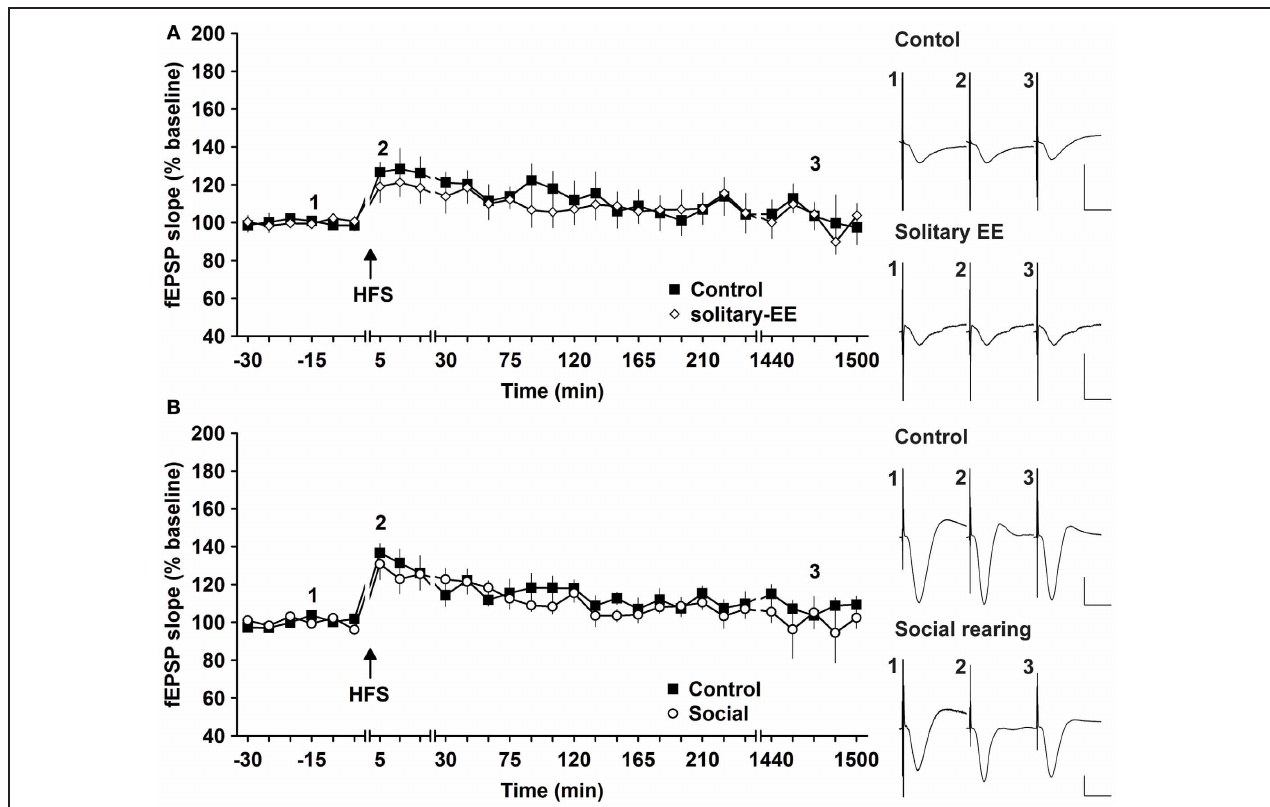
housing in the absence of EE had no effect on E-LTP. Time-point of high frequency stimulation (HFS) is marked with a filled arrow. Insets: Analog examples of field potentials (averages of five consecutive sweeps) from typical experiments at the time indicated by the numbers. Horizontal bar: 10ms, vertical bar: 2mV.